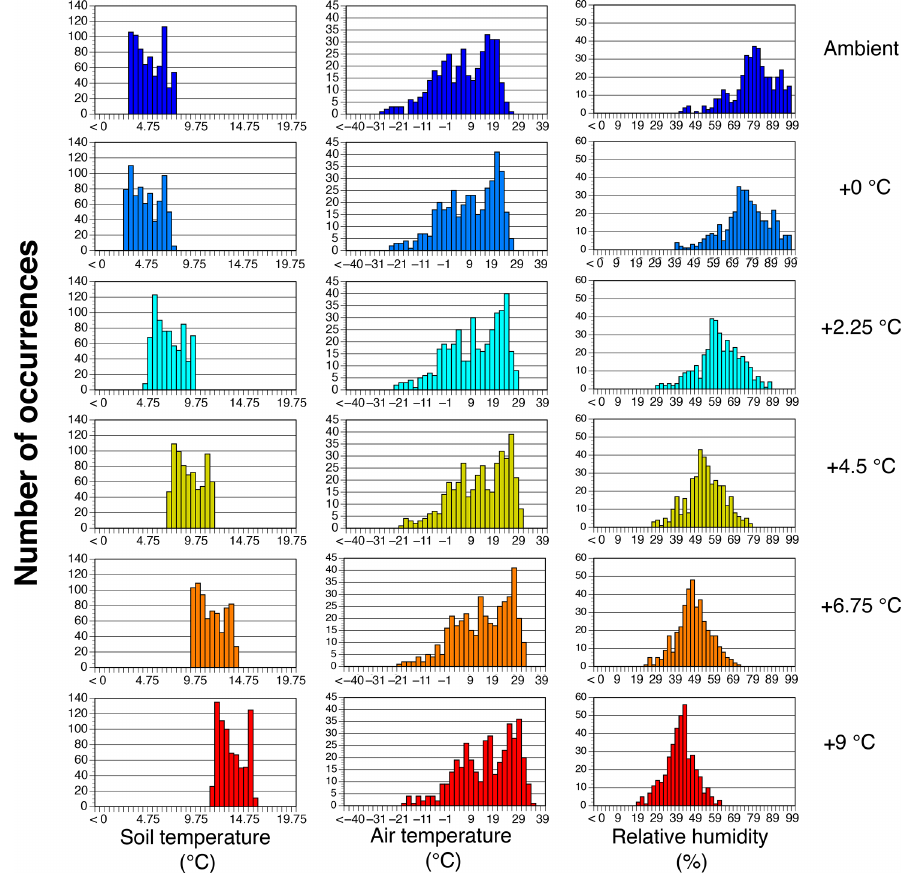
Figure 10. Frequency distributions for daily mean soil temperature at − 2m (left column), air temperature at + 2m (middle column) and daily mean relative humidity at + 2m (right column) throughout the evaluation period in 2015 and 2016. Data in the frequency distribution for soil temperature include the period from September 2014 to September 2016, which includes the deep peat heating period. Data in the frequency distributions for air temperature and relative humidity include data from August 2015 to September